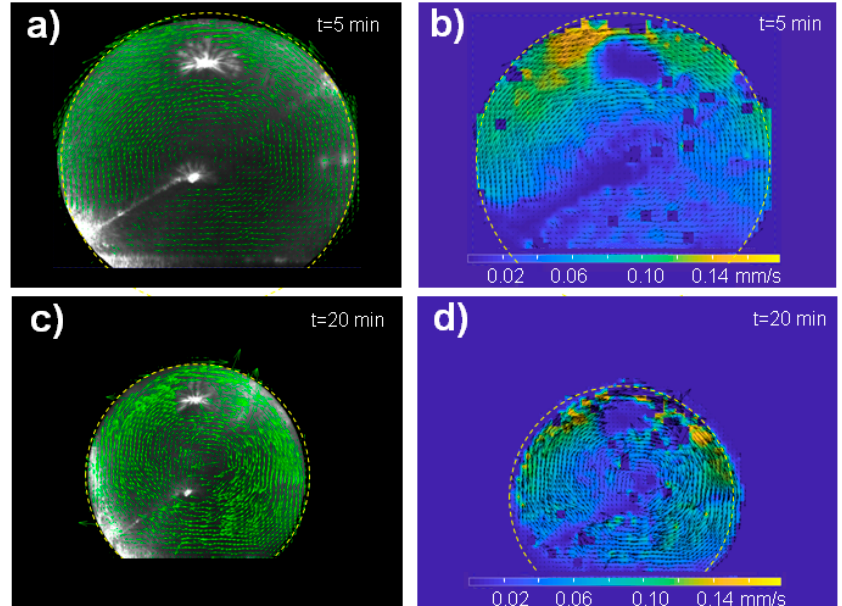
Figure 2. Particle image velocimetry (PIV) analysis of the water droplet loaded with polystyrene (PS) particles evaporating on an superhydrophobic surface (SHS). ( a , c ) Vector flow field of droplet at t = 5 and 20 min after the start of evaporation. The limit of the droplet is schematically indicated by a dashed yellow circle. The local magnitude of the vortex-like flow is proportional to the length of the vectors. ( b , d ) Heat maps of velocity magnitude distribution (in mm/s) overlaying the vector distribution at t = 5 and 20 min. Note the change in vector orientation for the two evaporation times.